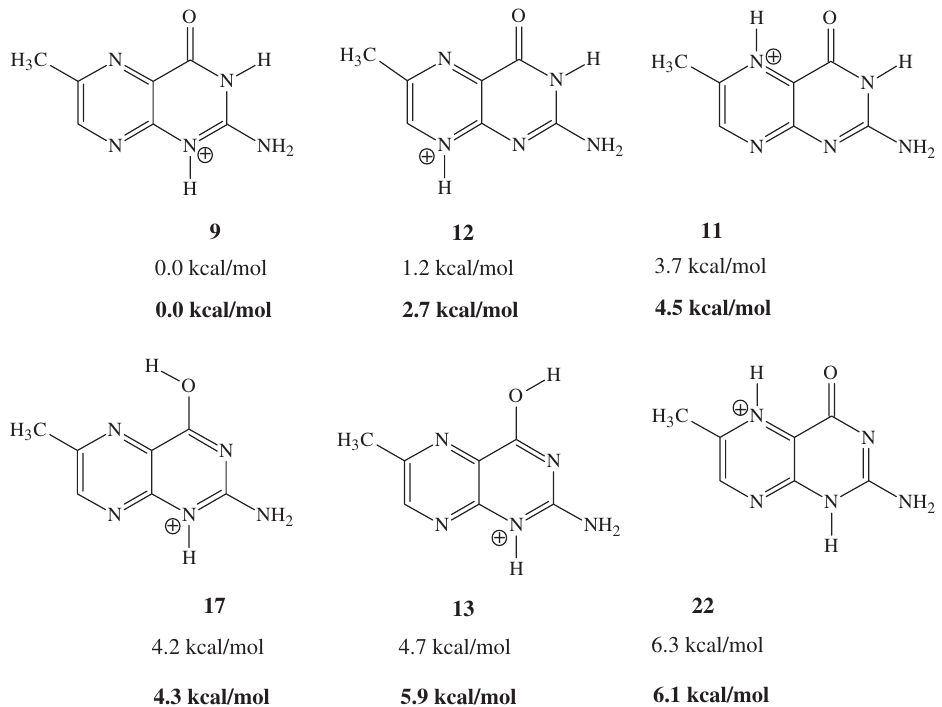
Figure 12 Relative calculated energies of the most stable protonated pterin cations (top: B3LYP/6-31+G**; bottom: MP2/6-31+G**, bold).